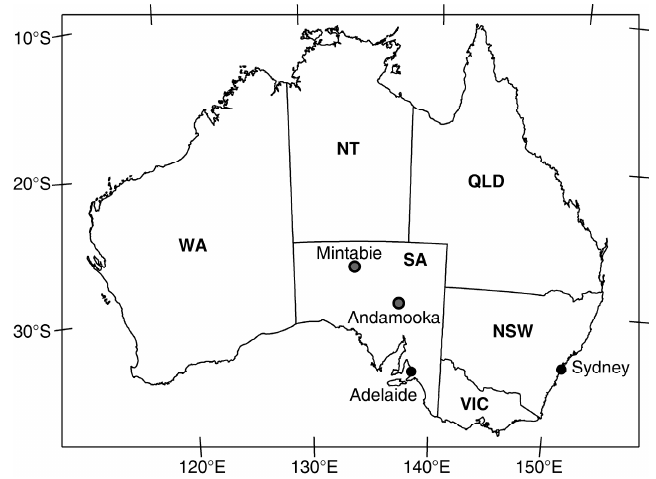
Figure 1. Location map of the sample sites in Andamooka and Mintabie (South Australia, Australia).